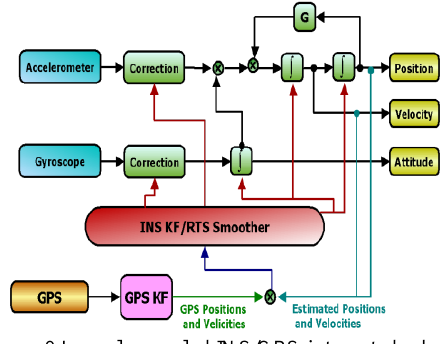
Figure 9 Loosely coupled INS/GPS integrated scheme